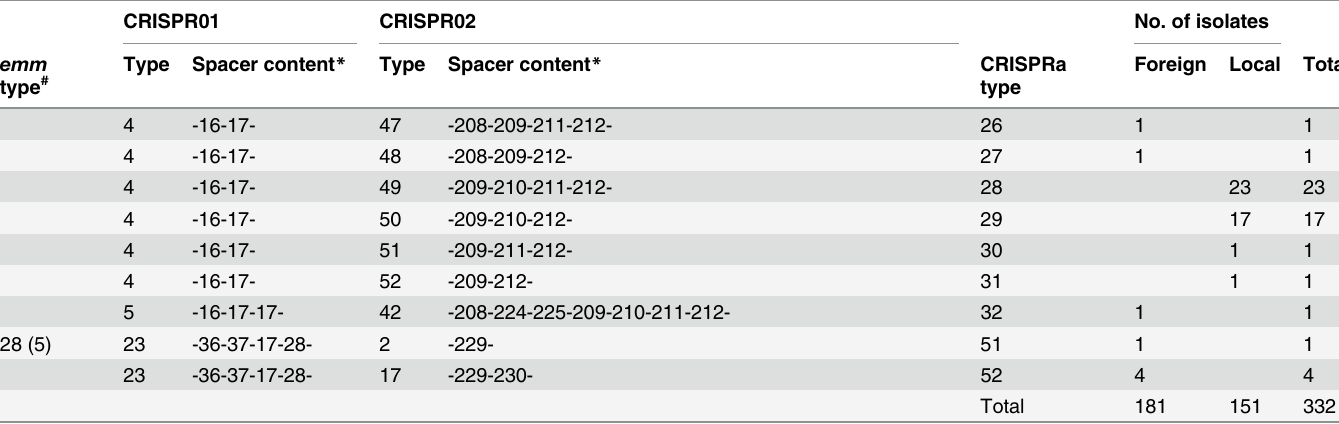
locus (Table 1). In emm 4 strains, 78.4% (40/51) had CRISPR02 type 13 (Table 2). Since most emm 4 strains were isolated from the local region, to rule out the possibility that CRISPR02 type 13 was the same clone, Sma l-digested PFGE typing was performed. The local emm 4 strains with CRISPR02 type 13 had different PFGE types (data not shown), suggesting that the strains with a conserved CRISPR02 type were not closely related. Together, these results sug- gest that each emm type had their dominant CRISPR type.